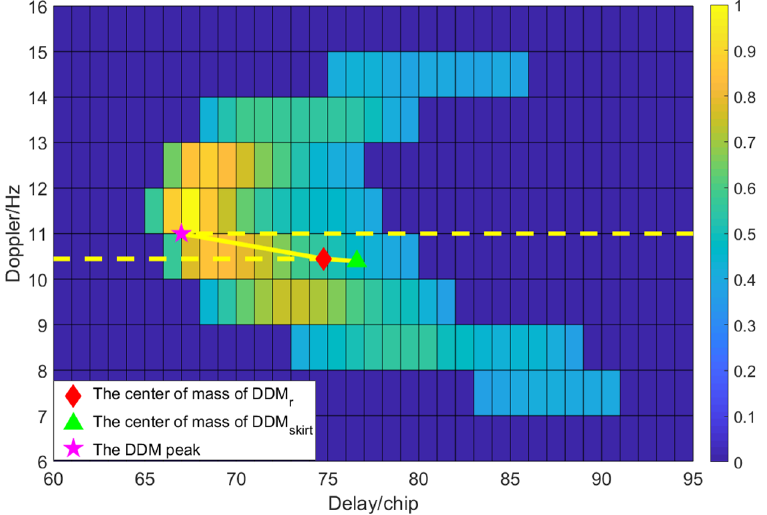
Figure 3. Extracting feature parameters of the geometric relationships φ 1 and φ 2 from the DDM of a 180° wind direction.